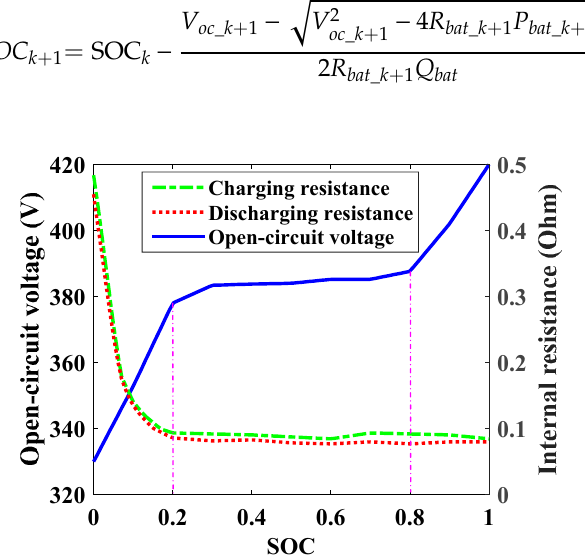
Figure 8. Characteristic curves of a lithium-ion battery pack.